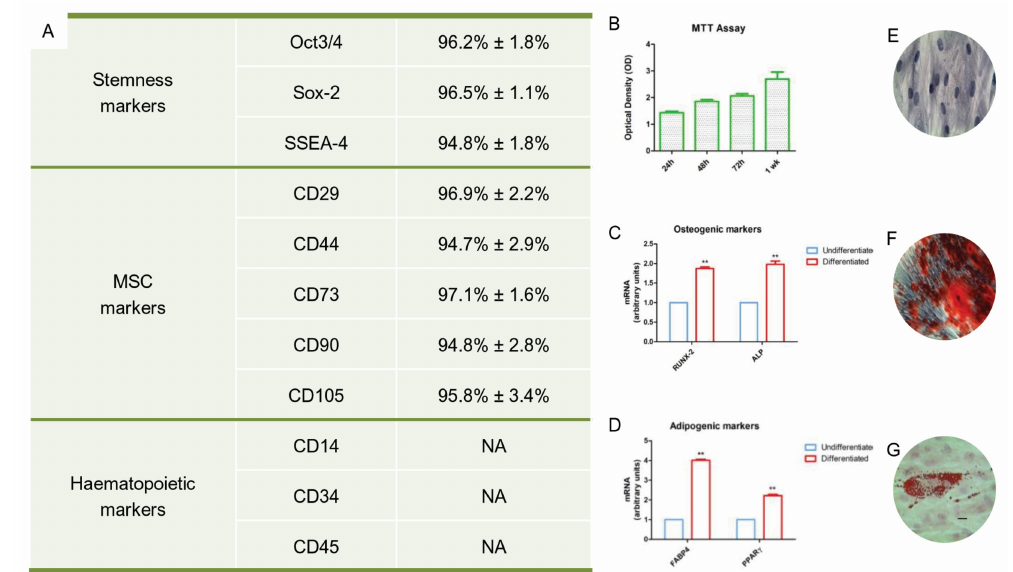
Figure 1. hPDLSCs characterization. ( A ) Flow cytometry of surface related markers at the 2nd passage. ( B ) MTT Graph showed the proliferation rate at different time of culture. ( C ) RT-PCR of osteogenic markers: RUNX2 and ALP. ( D ) RT-PCR of adipogenic markers: FAPB4 and PPAR γ . ( E ) Plastic adherent hPDLSCs stained with Toluidine blue solution ( F ) Alizarin Red S staining of hPDLSCs after 28 days of differentiation. ( G ) Oil Red staining of hPDLSCs after 28 days of differentiation. Mag: 10 × ( E ); 40 × ( F , G ), bar: 10 µ m. The ANOVA test ( p -value threshold of 0.05) was used to perform the statistical analysis between osteogenic and adipogenic